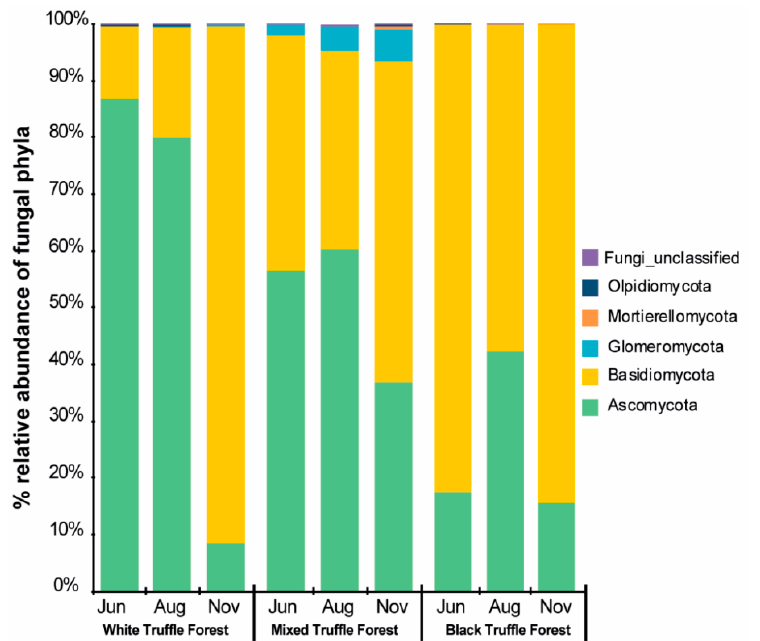
Figure 3. Relative abundance of root-associated fungal phyla of white, mixed, and black truffle-producing habitats across three different sampling months in Serbian riparian forests.